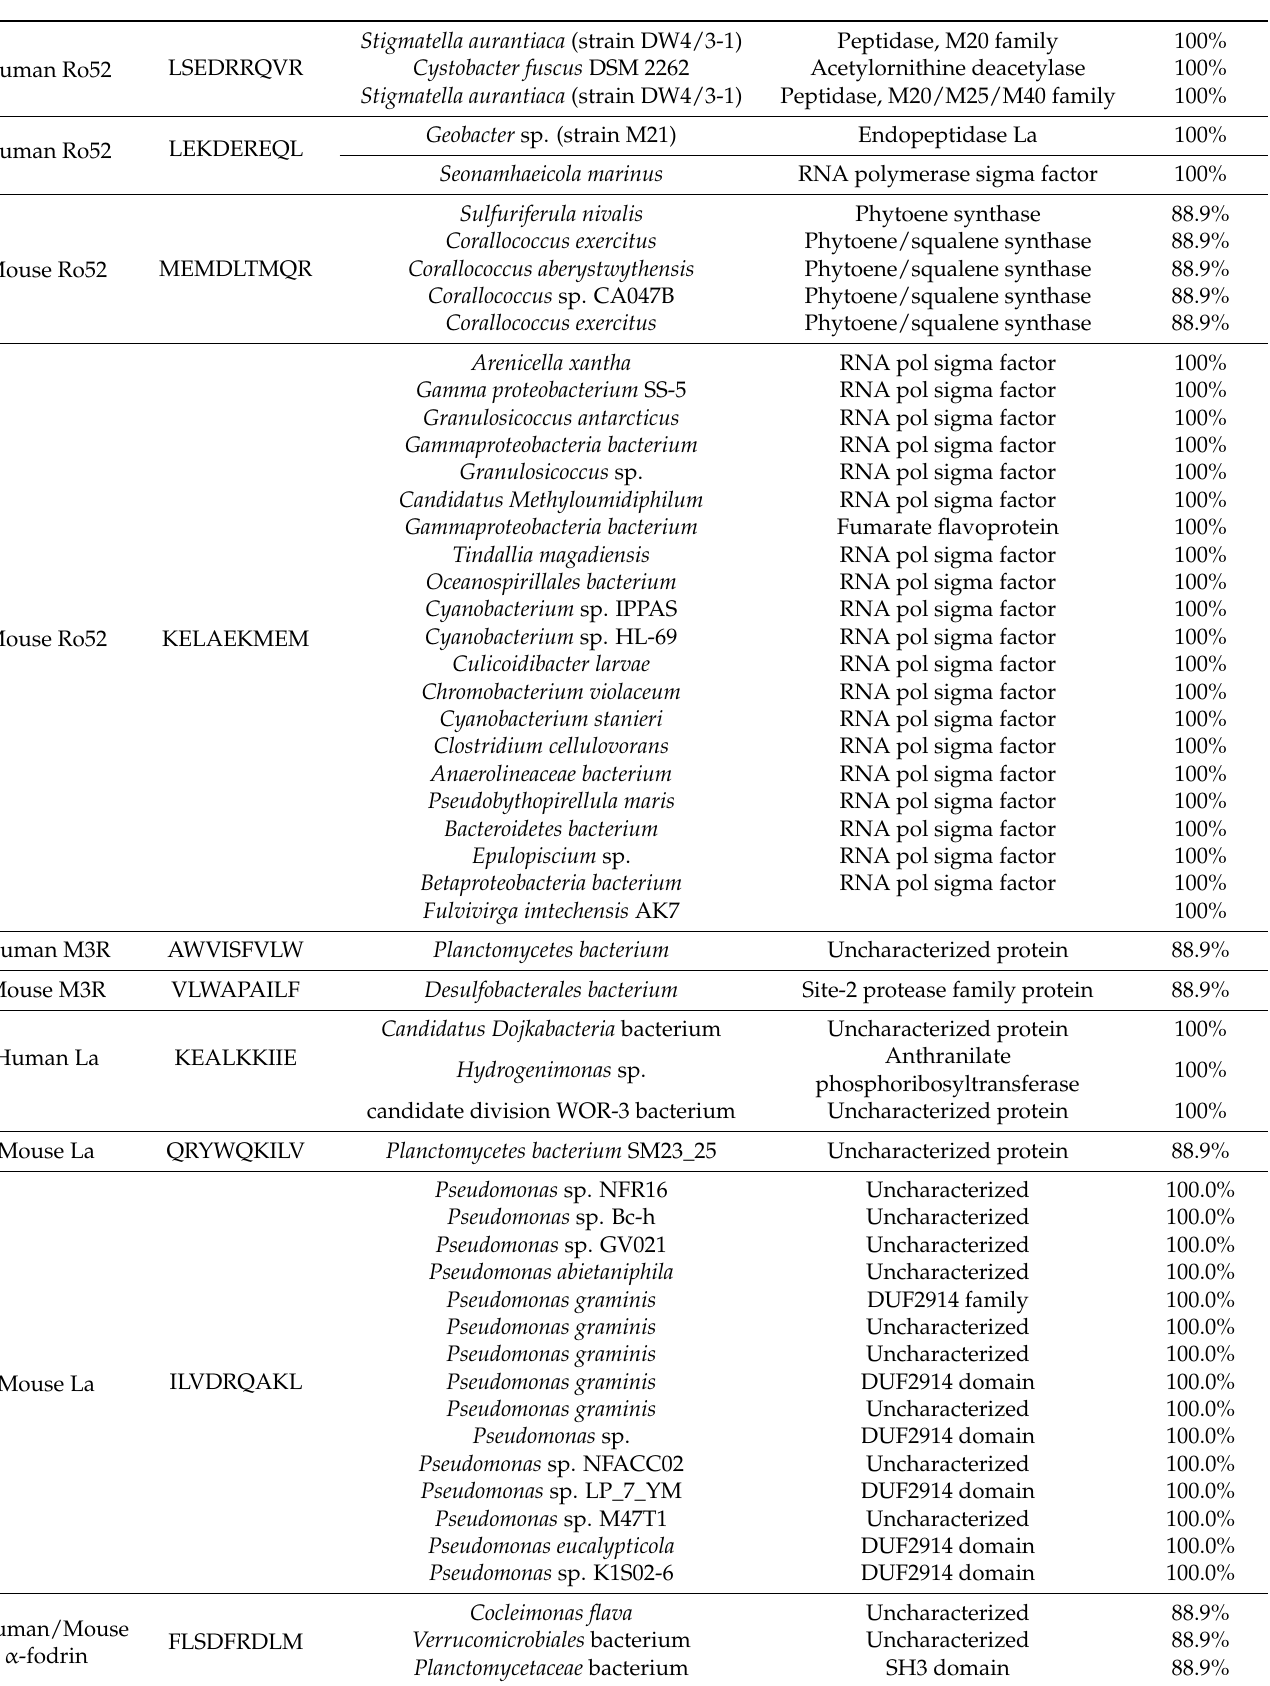
Table 15. Homology of predicted peptides binding to HLA-DRB1*03:01 to bacterial proteins.